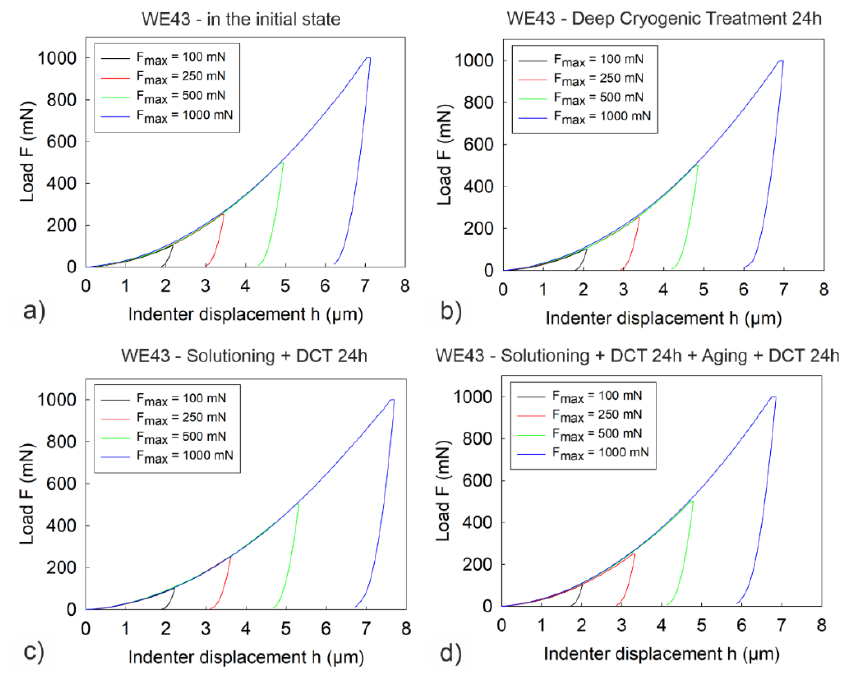
Figure 3. Load–unload curves F(h) for alloy WE43 in its initial state ( a ), after deep cryogenic treatment ( b ), after solution treatment and sub-zero treatment ( c ) and after precipitation hardening combined with deep cryogenic treatment ( d ).